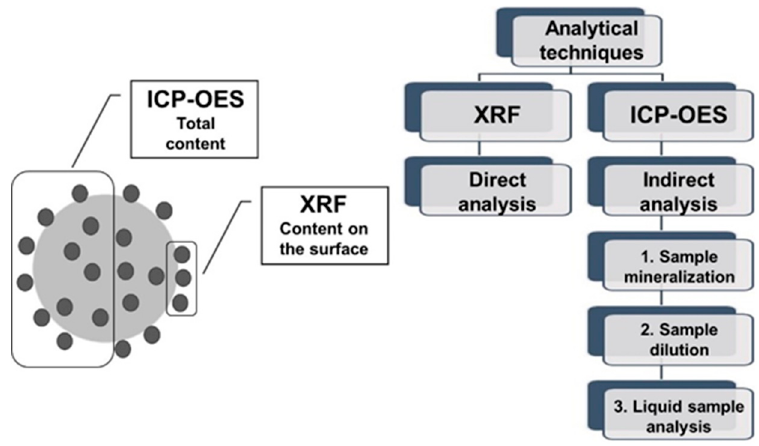
Figure 1. Comparison of ICP-OES and XRF in biosorption studies.